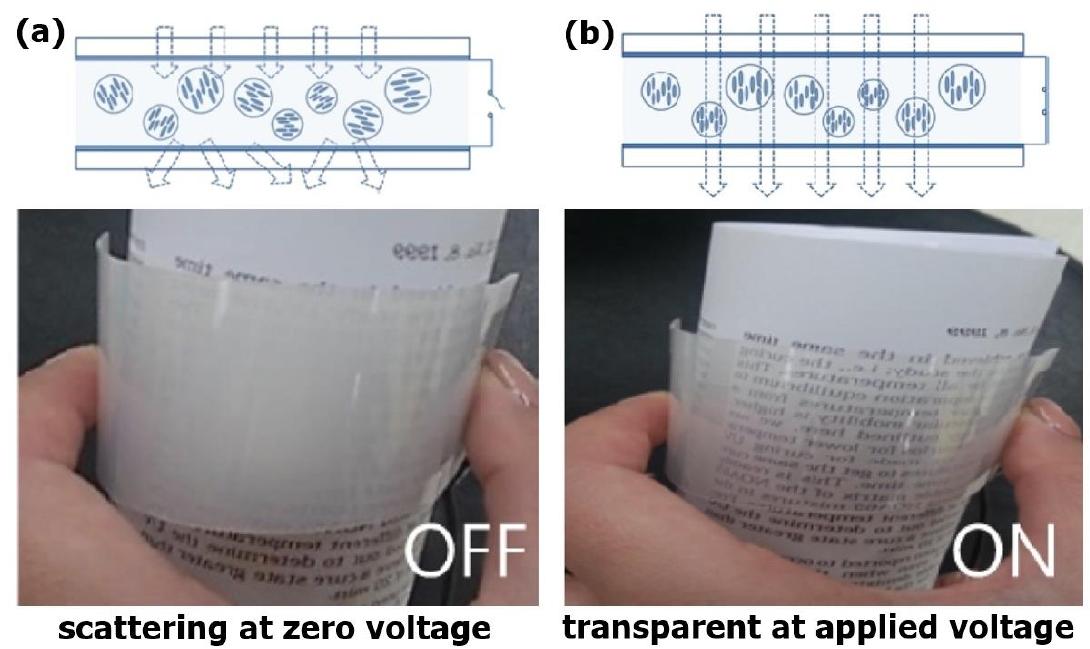
Figure 16. Schematic (top) and device example (bottom) of a polymer-dispersed liquid crystal (PDLC) flexible display with graphene electrodes in ( a ) the light scattering off-state and ( b ) the transparent on-state. Such switchable, flexible foils are used without polarisers, for example in smart and privacy windows. (Reproduced by permission from ref. [138]).